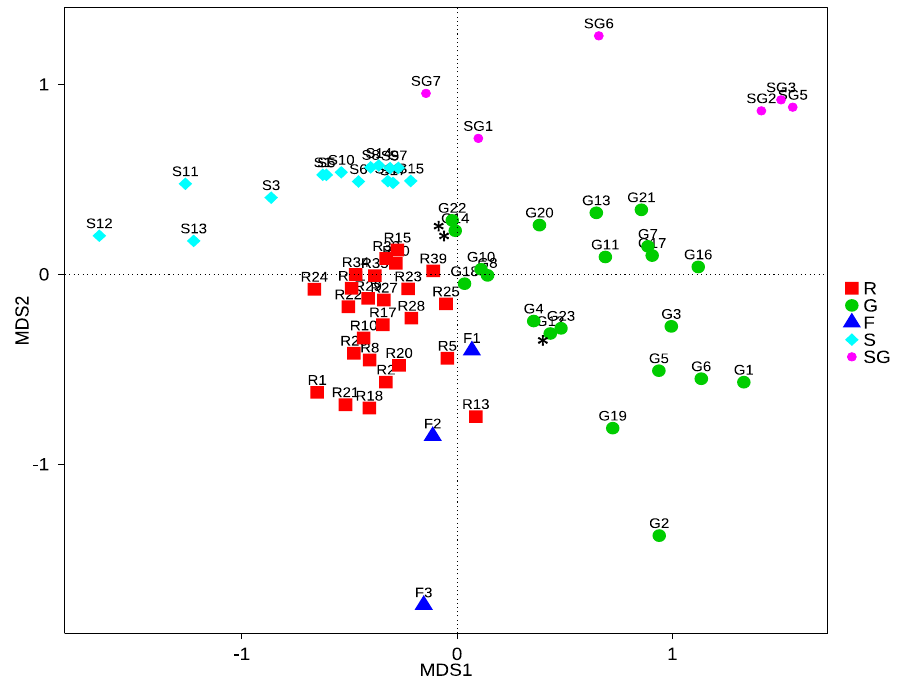
Figure 4. NMDS plot of leaf and seed HTS samples from Roosky, Glasnevin, and France. Legends on the right corresponds to R = leaves from Roosky, G = leaves from Glasnevin, F = leaves from France, S = Seed Roosky, and SG = Seed Glasnevin. Sample number is provided. Stress = 0.180. All samples are from F. excelsior except from the mixed Fraxinus taxon sample from G. For G, samples G12, G14, and G22 (highlighted with *) are from Fraxinus excelsior and all other G samples are from different Fraxinus species/taxa (as outlined in Table S2).